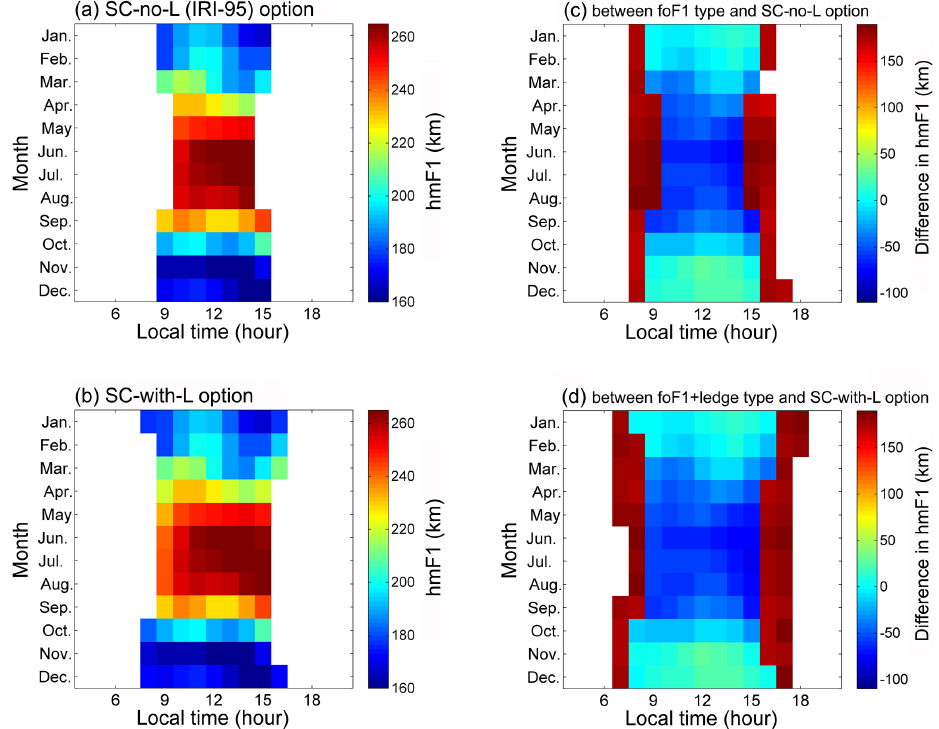
Figure 4. The monthly median hm F1 values for (a) SC-no-L and (b) SC-with-L options, modeled by IRI-2012 with the B0 choice of Gul- 1987, during January–December 1996. The differences in hm F1 (c) between fo F1 type and SC-no-L option, and (d) between fo F1 + ledge type and SC-with-L option are displayed.